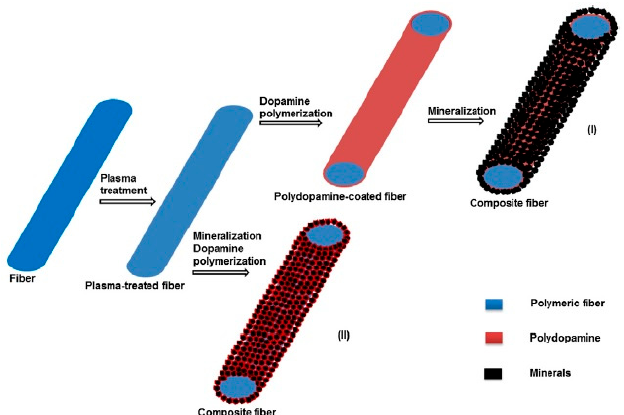
Figure 1. Schematic illustration of the formation of composite fibers. Method I: Plasma-treated electrospun polycaprolactone (PCL) fibers were coated with polydopamine prior to mineralization in 10xSBF. Method II: Plasma-treated electrospun PCL fibers were mineralized in the 10xSBF solution containing dopamine. Reproduced with permission from reference [107].